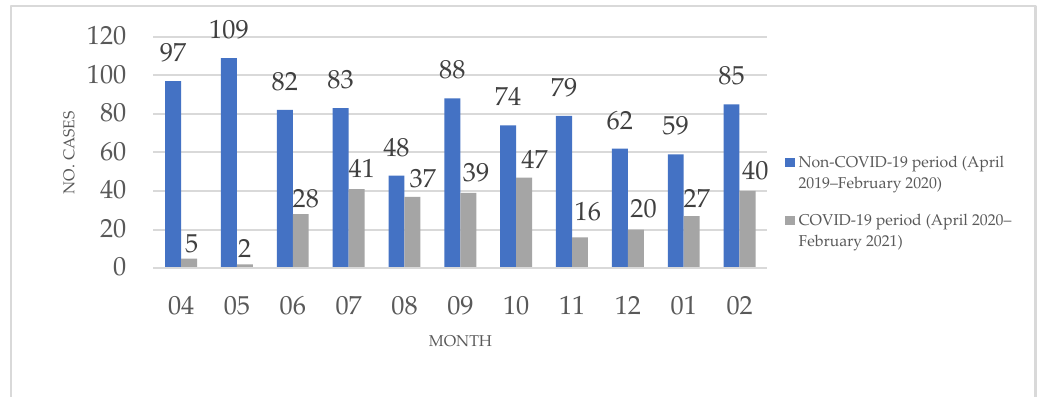
Figure 1. The monthly distribution of histopathological diagnoses established between April 2019 and February 2020 and between April 2020 and February 2021 in the dermatopathology ward of Mures Clinical County Hospital, Targu Mures, Romania.